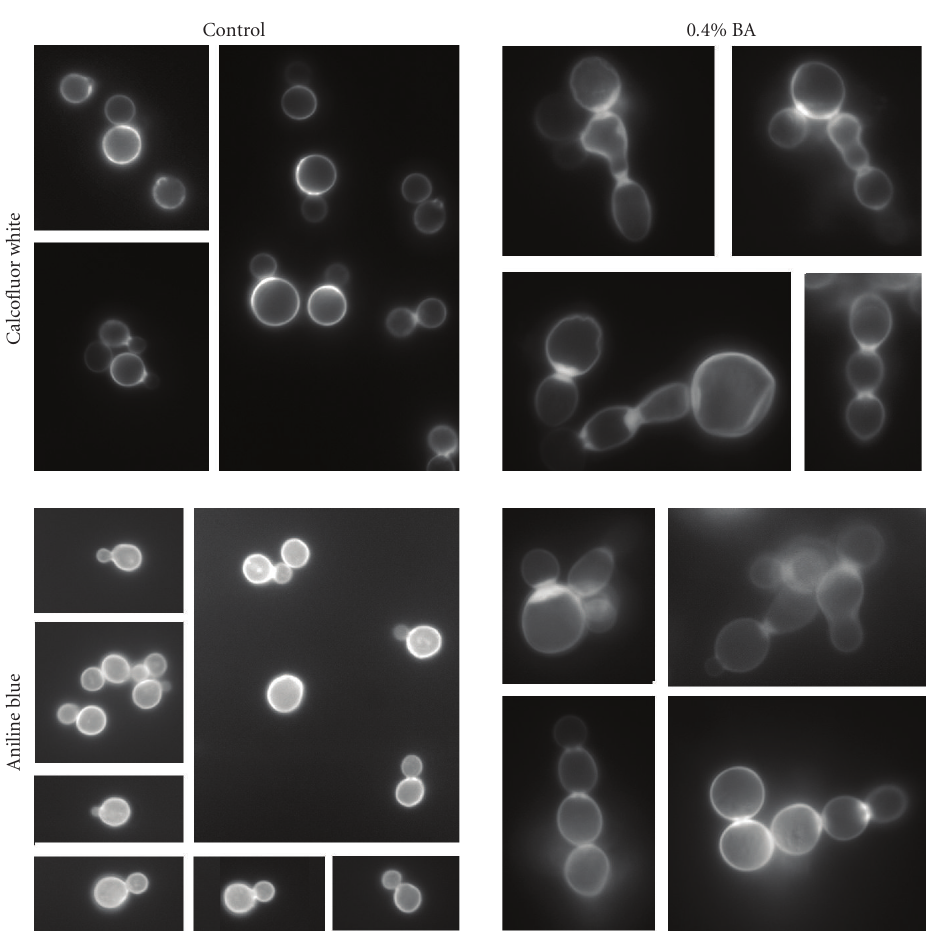
Figure 2: Analysis of chitin and glucan distribution in BA-treated cells: fluorescence of calcofluor white (top) and aniline blue (bottom) stained cells. At BA concentrations of 0.4%, chitin-rich—and to a lesser extent, glucan-rich—material accumulates at the bud neck. The thickening of septa is evident particularly between cells in a chain.